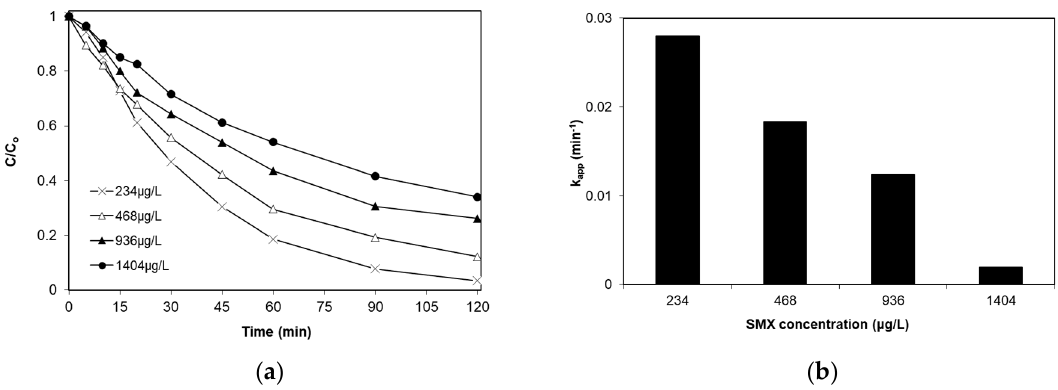
Figure 7. Effect of initial SMX concentration on its photocatalytic degradation in UPW ( a ) and apparent kinetic constants ( b ). [0.04%Fe/TiO 2 ] = 1 g/L and natural pH. Inset: Apparent kinetic constants.